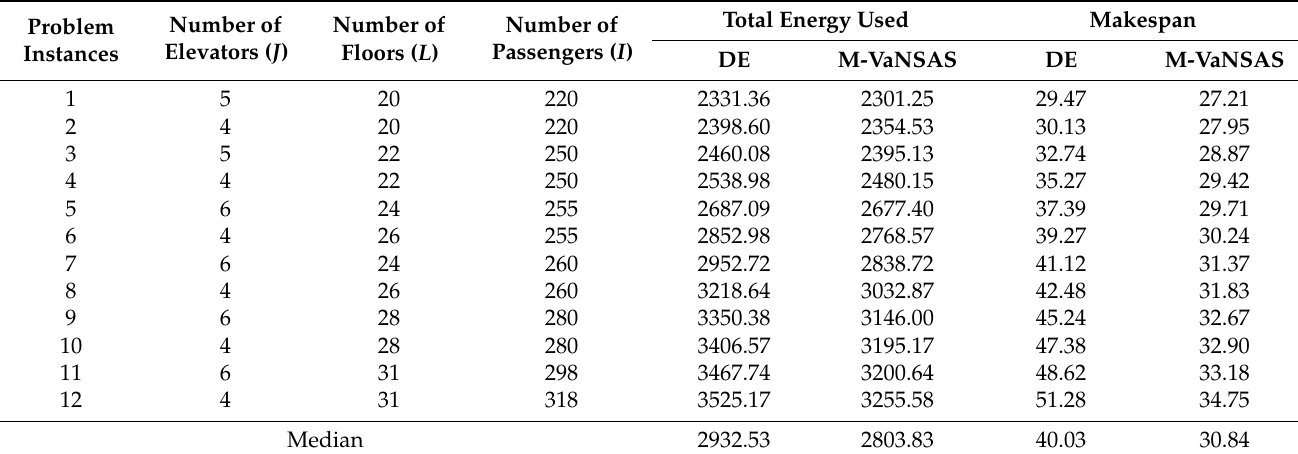
Figure 6. Pareto front of M-VaNSAS. Table 7. Energy used and the makespan of the elevator using 𝑤 (cid:2869) = 0.5 and 𝑤 (cid:2870) = 0.5 .